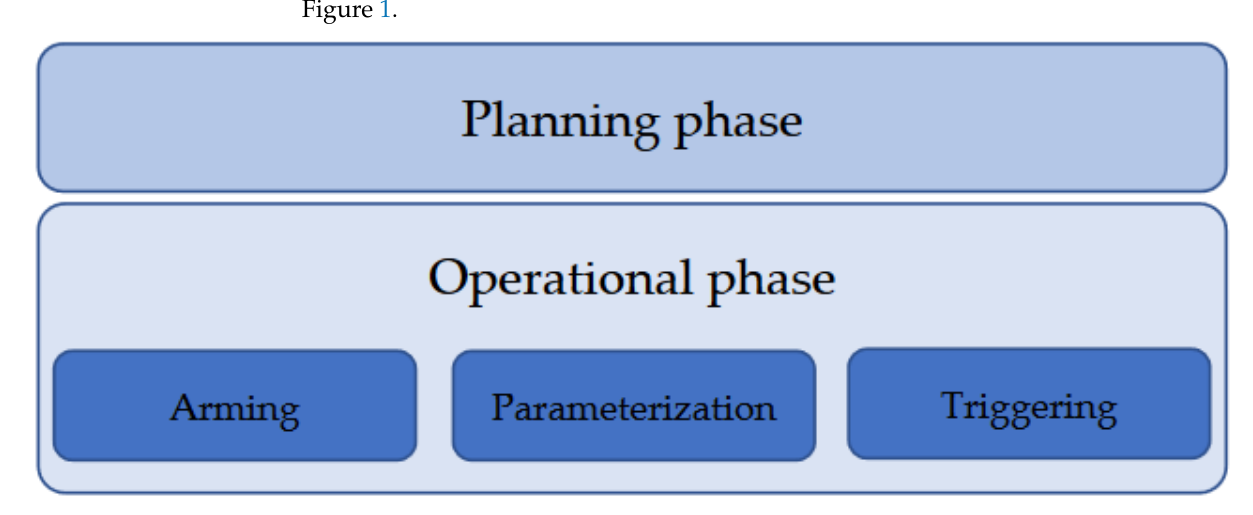
Figure 1. SIPS planning and operation phases and execution steps.